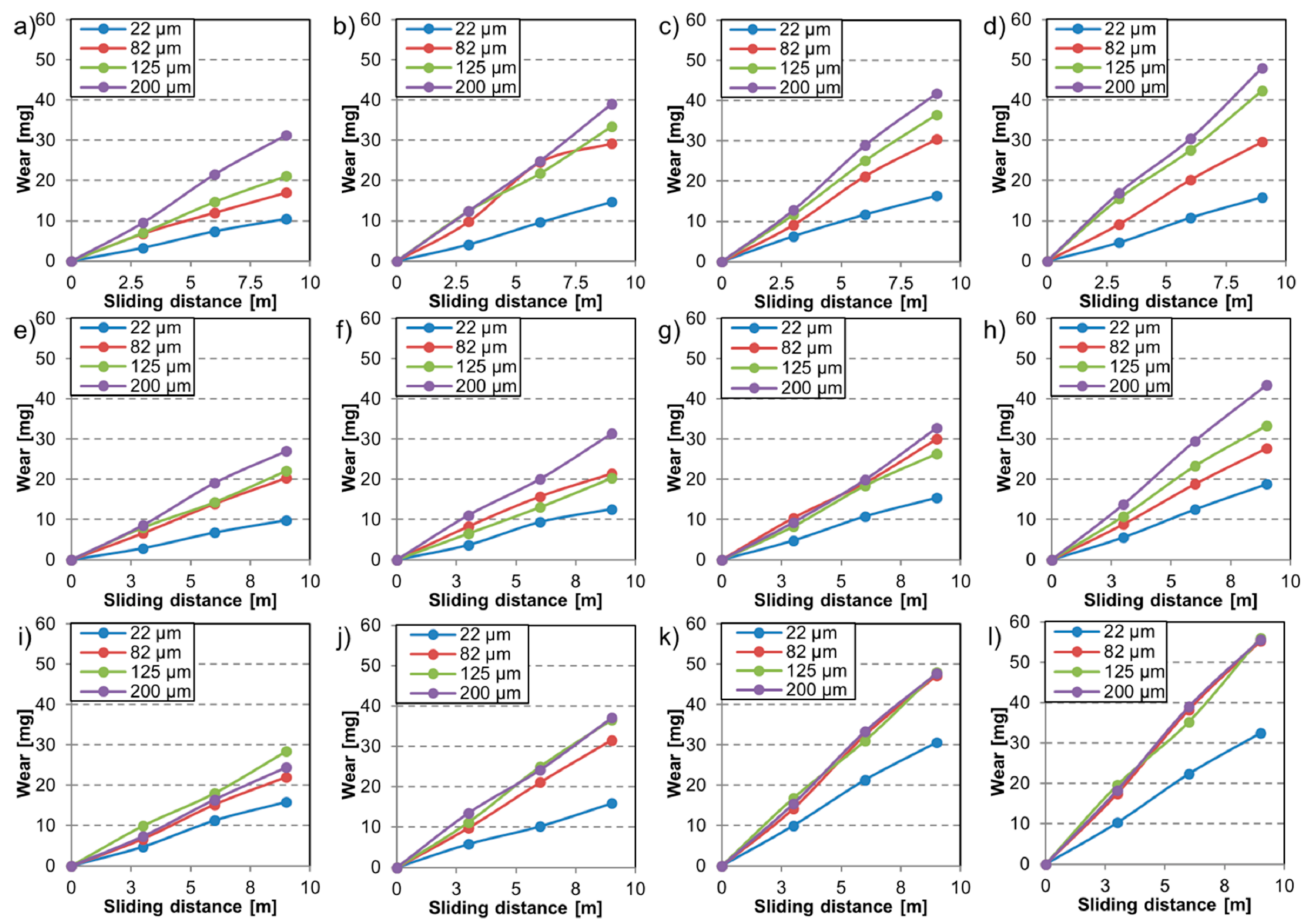
Figure 7. Wear (mg) in function of sliding distance for different abrasive particle sizes (22 µ m, 82 µ m, 125 µ m, 200 µ m) and increasing load (4.5 N, 11.2 N, 17.4 N, 24.2 N) for material FM ( a – d ), material TM ( e – h ), and MP steel ( i – l ).